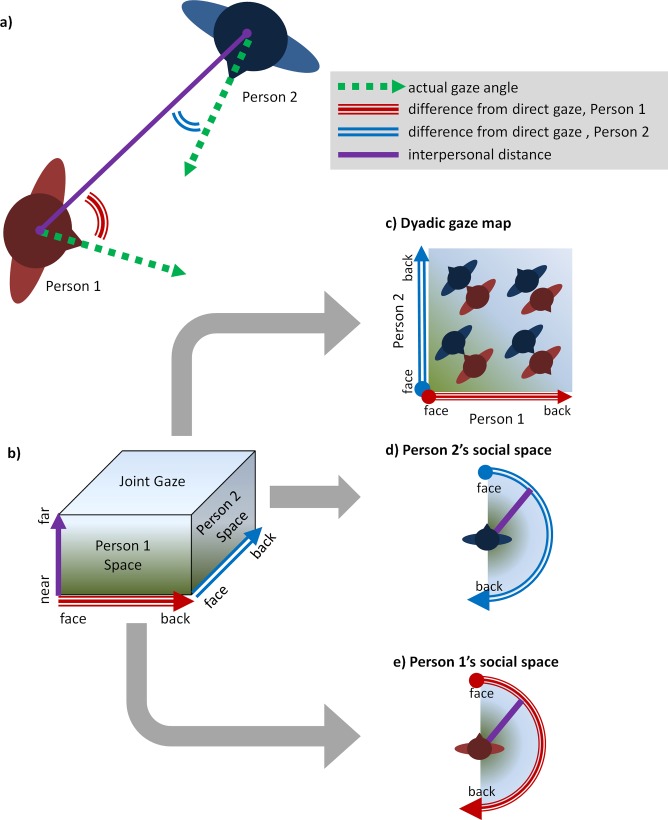
Proxemic imaging.Proxemic images are frequency maps of digital tracking data created using three data points (a): the distance between the two people, and the differences from direct gaze for each person. Each sample of tracking data is binned into a three dimensional space defined by these variables (b). By collapsing across any one of these dimensions, we produce (c) a map of the gaze patters of the dyad (i.e., from face-to-face to back-to-back) as well as (d and e) bird’s eye views of the space around either person.